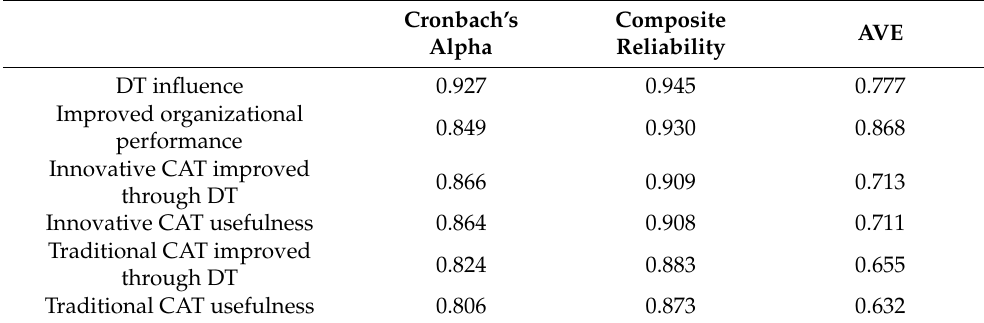
Table 4. Validity and reliability.